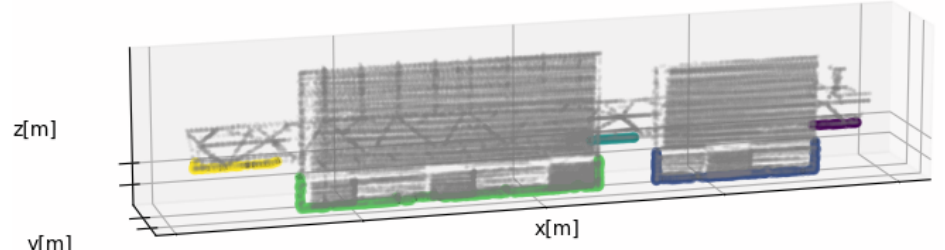
Figure 4. Each color/cluster represents part of the gantry bottom edge.